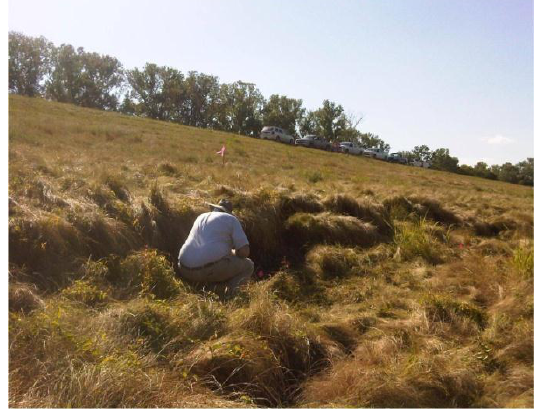
Figure 2. A typical levee slide. This one appeared in the spring of